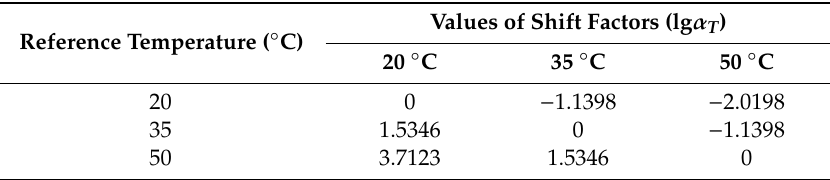
Table 7. The values of shift factors at di ff erent reference